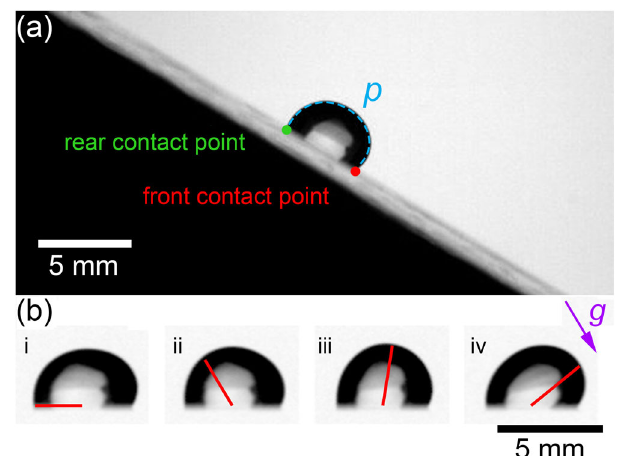
Fig. 2 Descending polymeric drop. a Snapshot of a 30 μ l polyacrylamide solution (PAA 10 /water 5000 ppm) drop moving downward on a 30° tilted surface. The free contour of the drop is indicated by a dashed curve of length p connecting the rear and front contact points. b Snapshots of the same drop taken at time intervals of 1/4 of the oscillation period; red lines highlight the evolution of the drop